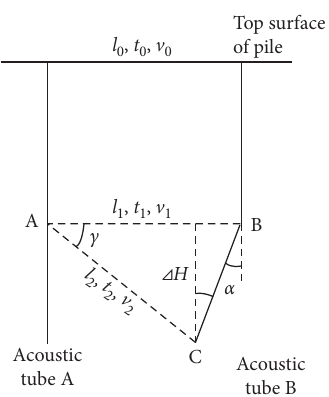
Figure 8: The schematic diagram of the pile with the inclined acoustic tube.